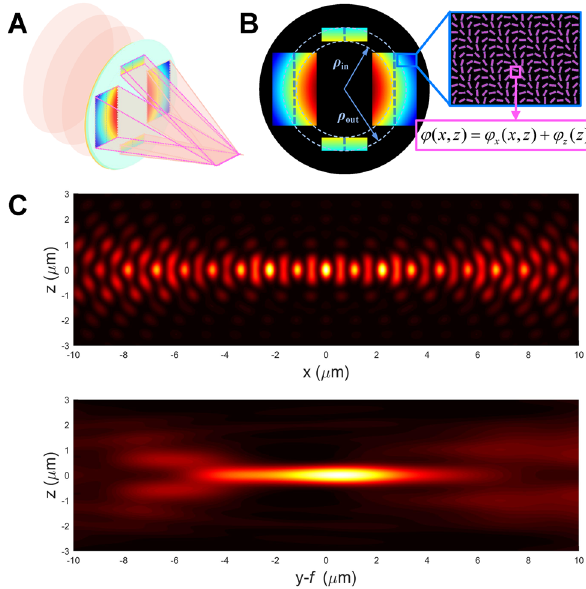
Figure 3: (A) Schematic view of the diffracted light waves from the metasurfaceblockswithspatialphaseprofilesin(B).(B)Bytailoring the orientation angle θ of the GaN nanopillars, the metasurface blocks are designed to have spatial phase pro fi les de fi ned by Equation (5). (C) Simulated xz and yz cross-sectional intensity distributions of the produced square-lattice